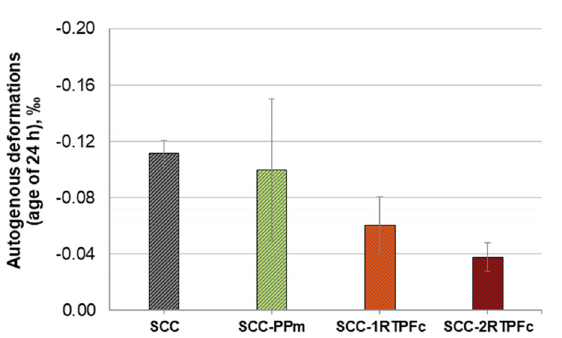
Figure 10. Autogenous deformations for SCC mixes at the end of the testing period (age of 24